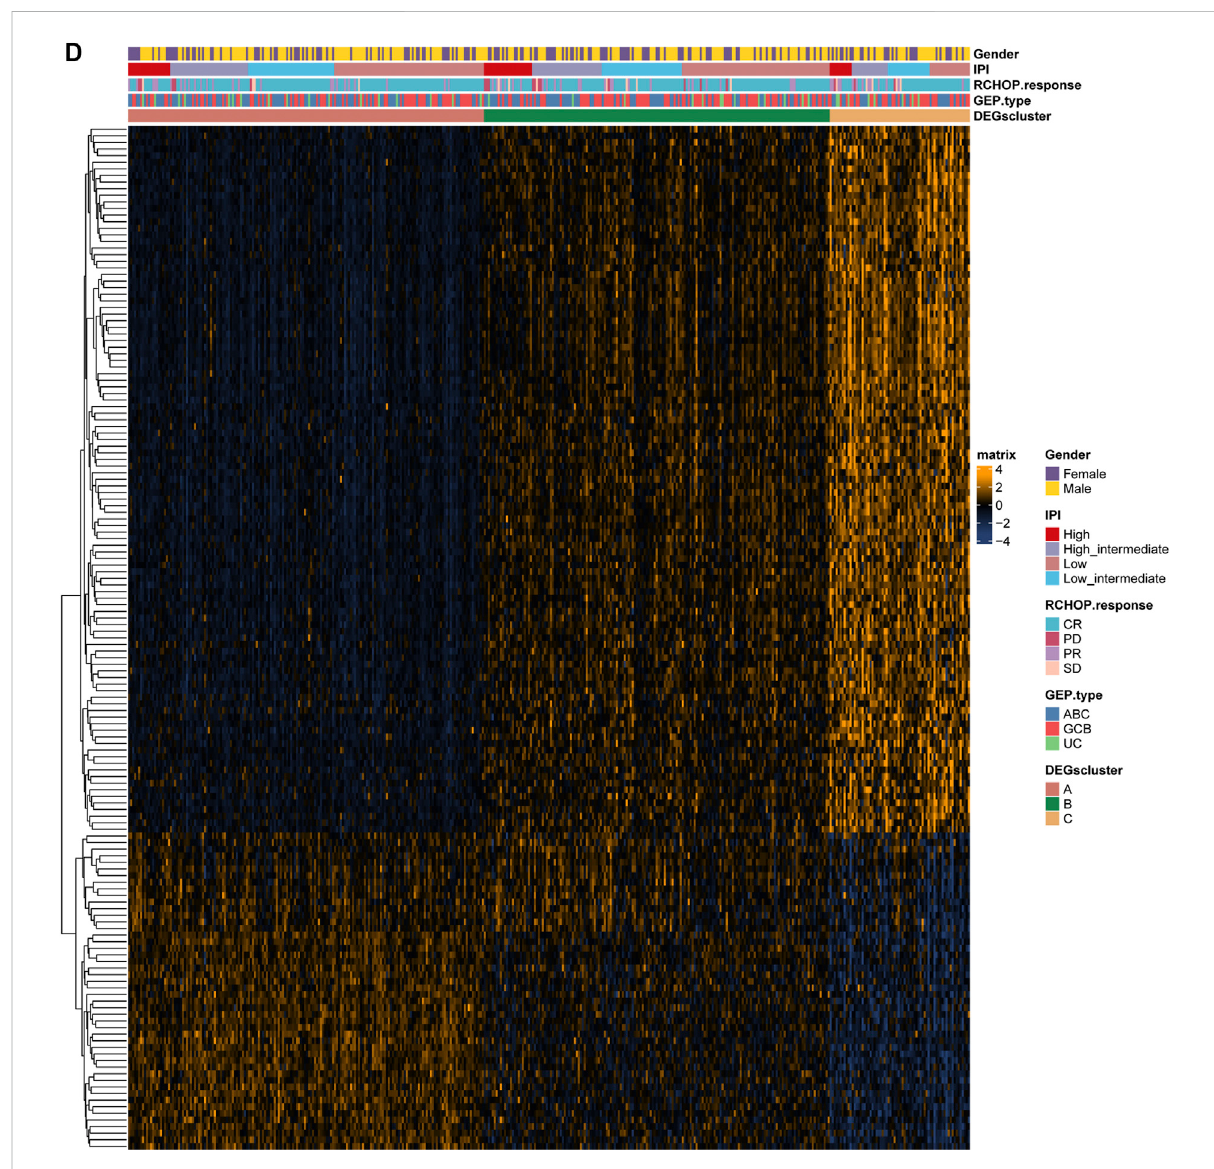
FIGURE 5 Cluster-related differentially expressed genes identi fi cation and secondary clustering. (A) Three circles represent the pairwise differentially expressed genes results between clusters, the middle dark blue represents common intersection, containing 155 genes in total. (B) PCA shows the differentialsituation ofthree differential generelated clusters. Blue dotsrepresent cluster A,yellow dots cluster B, and reddots cluster C. (C) Survival analysis of clusters related to differentially expressed genes. Blue represents cluster A, red cluster B, and green cluster C. Cluster A has the best prognosis. (D) Heat map of 155 genes integrating clinical features, with yellow representing upregulated expression and blue indicating